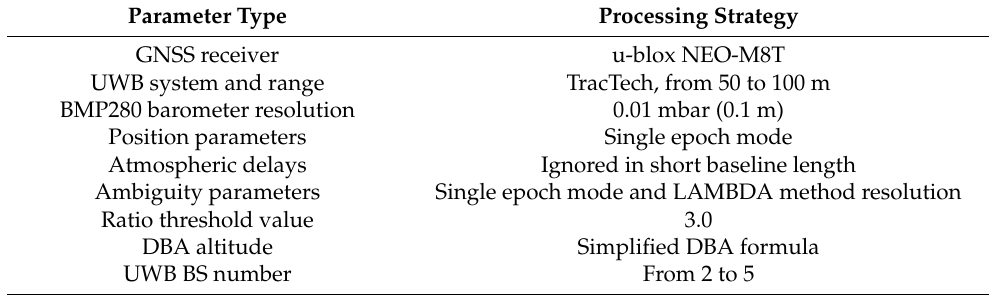
Table 1. GNSS RTK/UWB/DBA fusion positioning data processing strategy and parameter set.